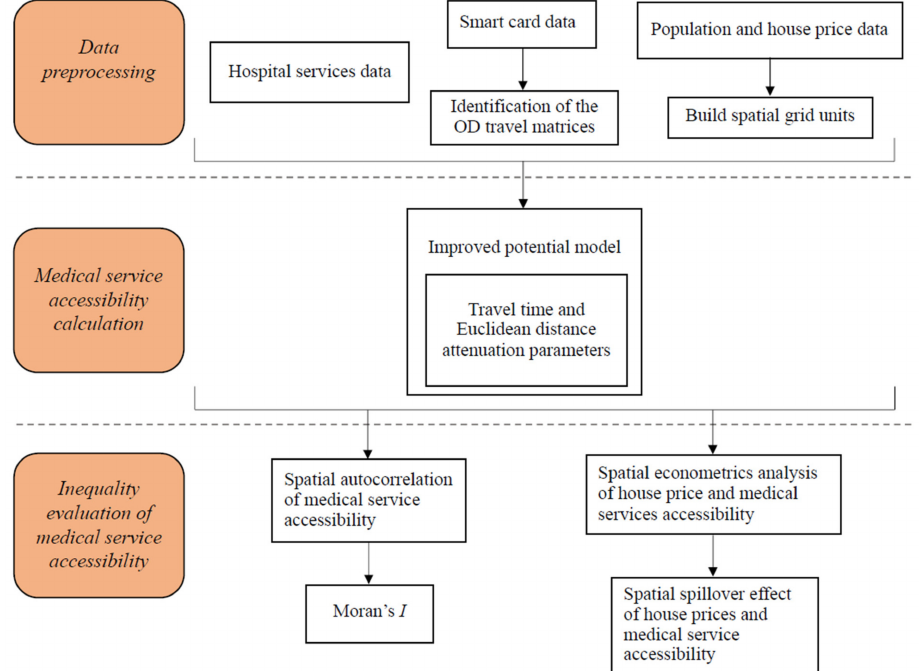
Figure 6. Workflow of the